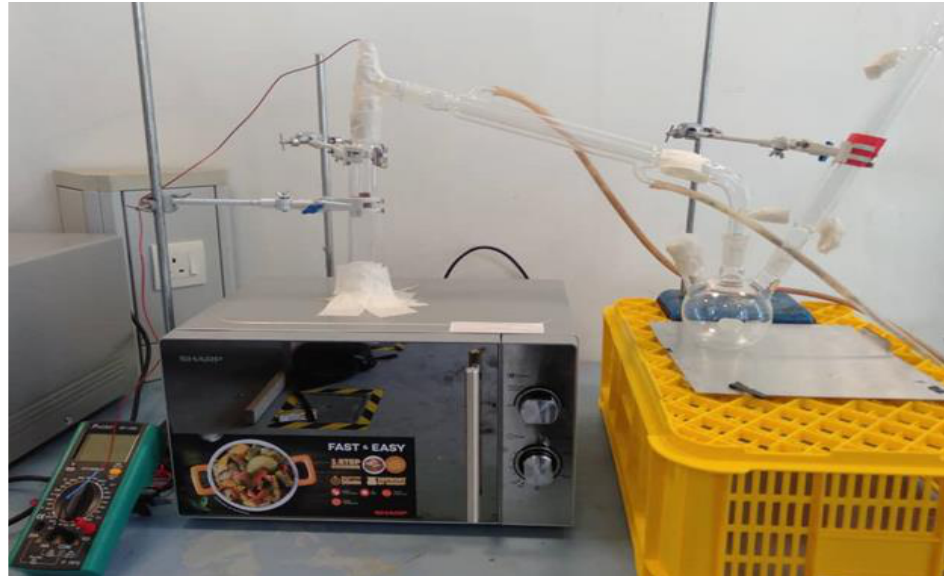
Figure 1(b): Modified microwave-assisted experimental set up for hydrothermal liquefaction process